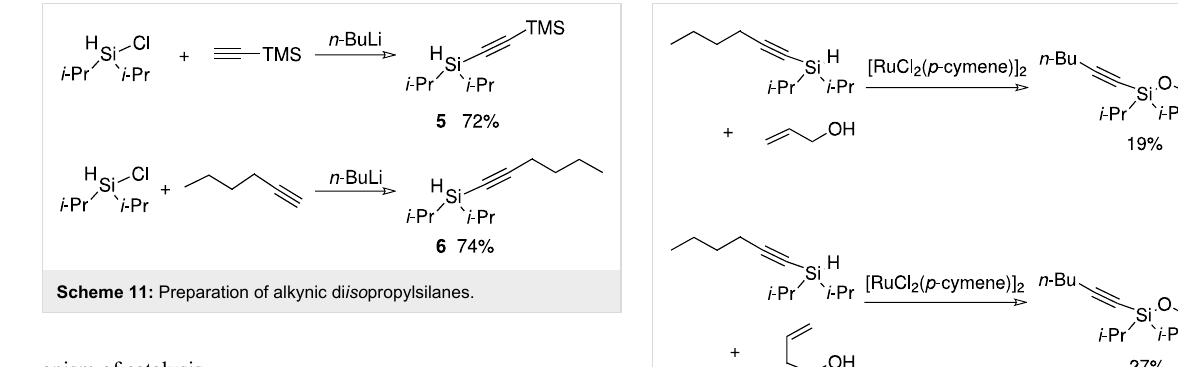
anism of catalysis.